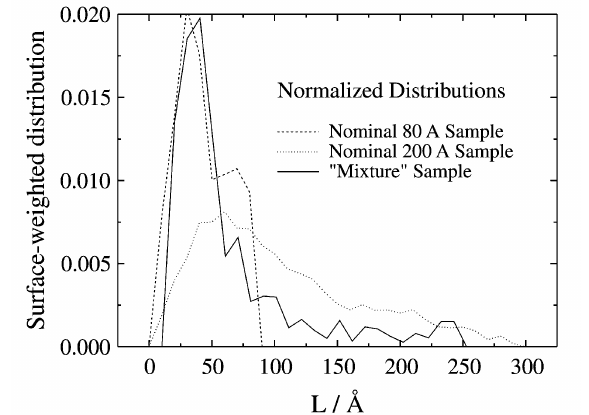
Figure 5. Surface-weighted distribution as a function of crystallite sizes for the three